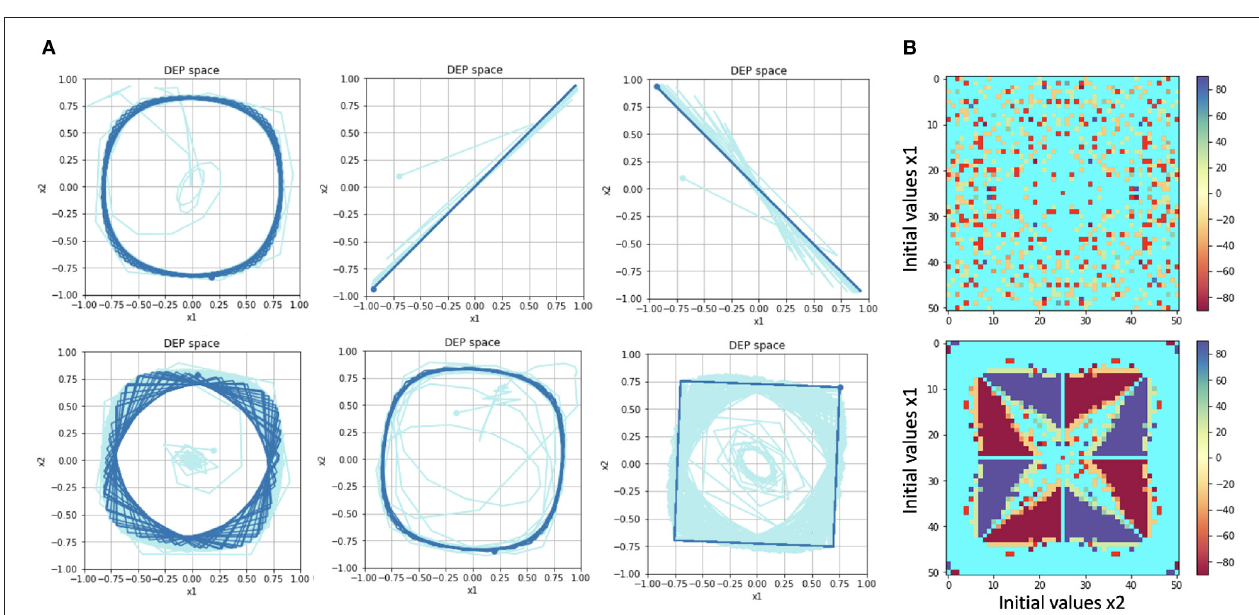
FIGURE 2 | (A) Examples of limit cycles reached by “Short-circuit” DEP. The phase diagrams show the trajectory of the system along the dimensions x 1 and x 2 . The second and third trajectories oscillate between two endpoints. The other trajectories are all rotational. (B) Maps of the attractors reached based on initial values of x 1 , x 2 . The color bar refers to the rotational angle of the attractor, in the case of rotational attractors. Cyan refers to the non-rotational attractors shown in the second and third examples in (A) . The resulting map is shown in the top row. The map in the lower row reproduces the one shown in Pinneri and Martius (2018), but to generate it requires slightly altering the DEP algorithm (see text). Our version lacks their basins of